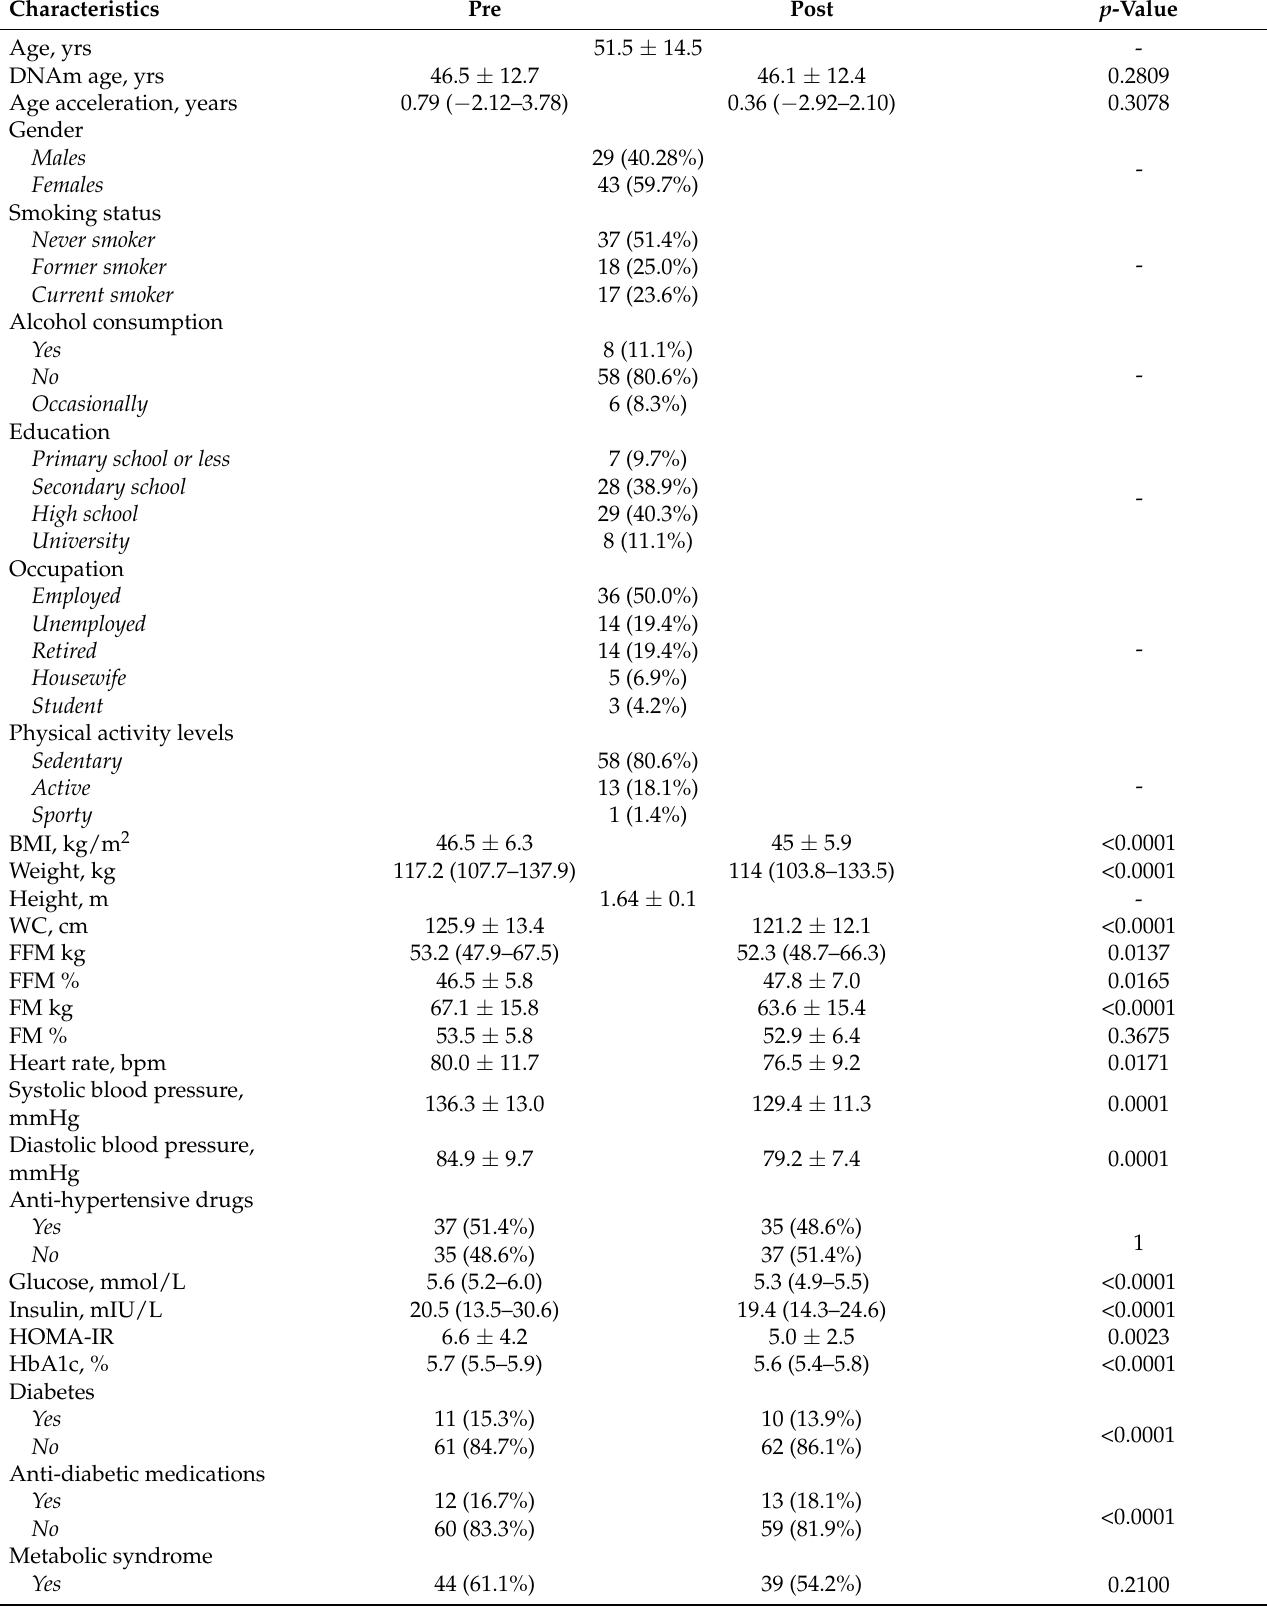
Table 1. Demographic, lifestyle, biochemical, and clinical characteristics of participants (N = 72) at the study: comparison pre- vs.